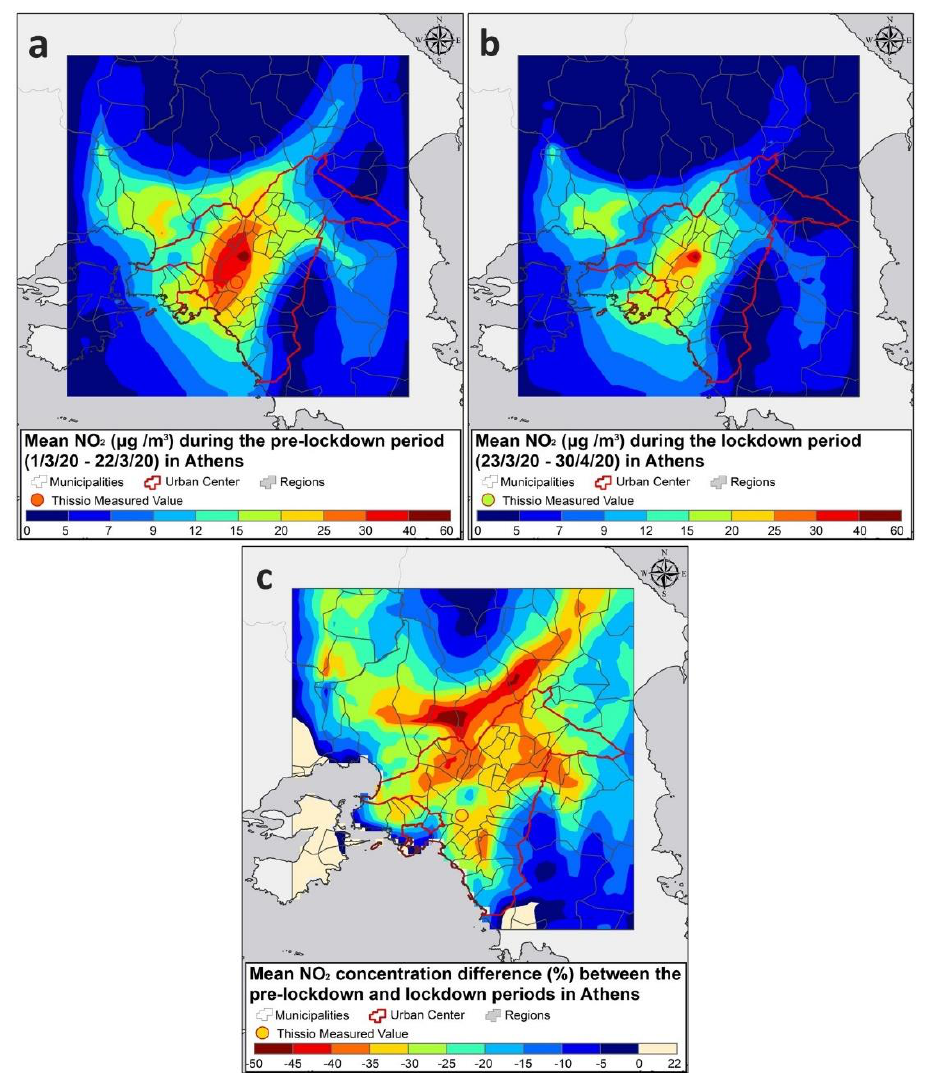
Figure 4. Mean surface NO 2 ( a ) concentrations (μg m −3 ) during the pre-lockdown period (March 1–22), ( b ) concentrations (μg m −3 ) during the lockdown (23 March–30 April 2020), ( c ) percent (%) changes between the pre- and lockdown periods, as predicted over the Greater Area of Athens (GAA). The location and the mean measured value of the Thissio monitoring site is indicated by a circular colored marker.